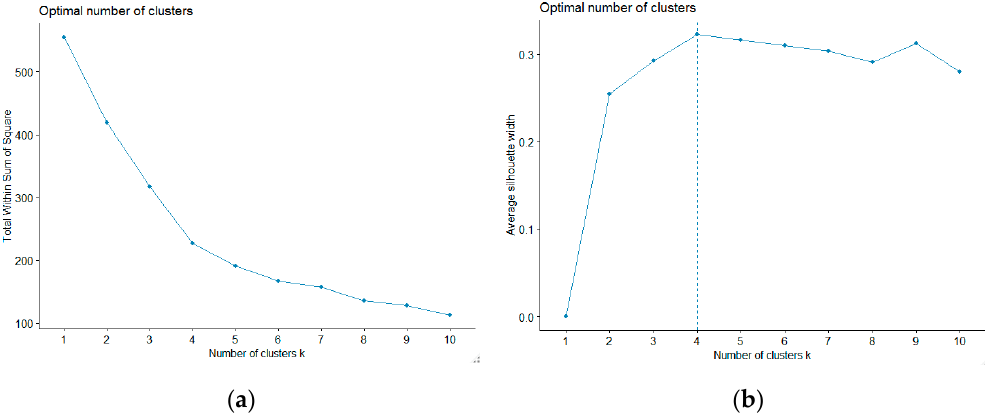
Figure 1. Optimal number of clusters methods results: ( a ) Elbow method and ( b ) Silhouette method.